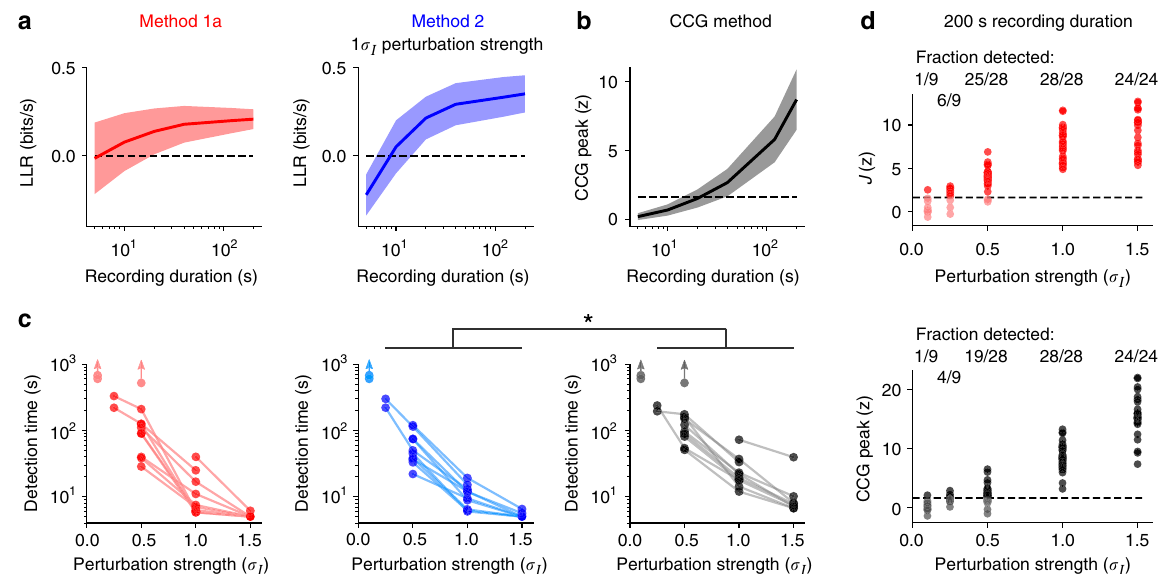
Fig. 4 Estimation results for arti fi cial synaptic input perturbations using in vitro data. a Log-likelihood ratio (LLR) of the I&F model with/without coupling on test data (10-fold cross-validation) as a function of recording duration for fi xed aEPSC strength (in unit of σ I , the standard deviation of the fl uctuating input current) using methods 1a (left) and 2 (right). Shaded areas in a and b denote mean ± standard deviation across all cells. LLR > 0 indicates successful detection. b CCG peak z -score as a function of recording duration for aEPSC strength 1 σ I . Dashed line indicates the signi fi cance threshold (95th percentile of the standard normal distribution). c Detection time for each cell as a function of aEPSC strength (in unit of σ I ) for method 1a (left), 2 (center), and the CCG method (right). Lines connect detection results for the same cell, light dots denote misses. In those cases, the detection time, if it exists, must be longer than the recording length, as indicated by arrows. * signi fi cant reduction of detection time ( p = 0.0276, two-tailed paired t test, sample size n = 32). d Estimated perturbation strength z -score using method 1a (top) and CCG peak z -score (bottom), both as a function of aEPSC strength for 200 s recording length. Recordings were split into 200 s segments with up to 40 s overlap. Dashed lines indicate the signi fi cance threshold (cf. b ). Dark dots